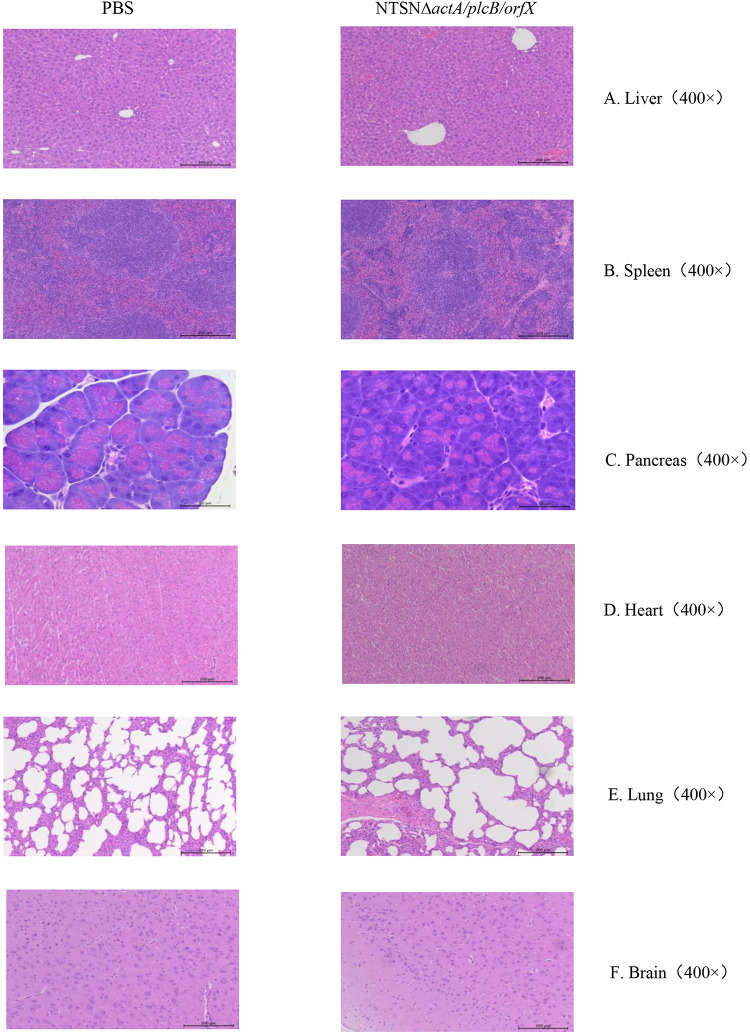
Histopathology of organs from mice injected with PBS or NTSNΔactA/plcB/orfX. (A) Liver (400 ×). (B) Spleen (400 ×). (C) Pancreas (400 ×). (D) Heart (400 ×). (E) Lungs (400 ×). (F) Brain (400 ×).